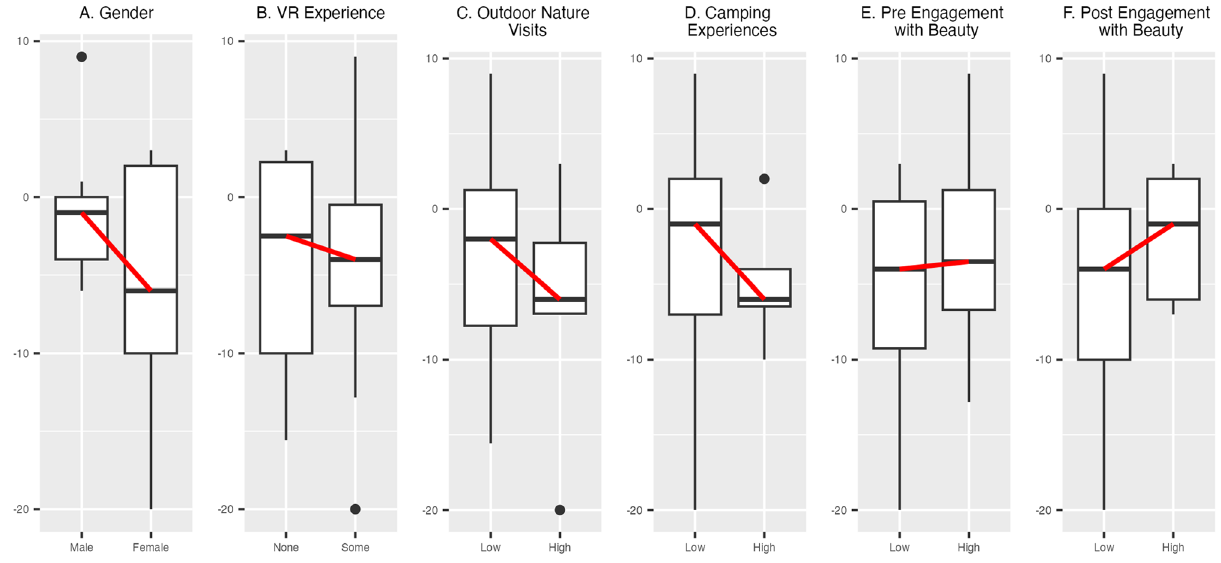
Figure 2. Moderating effects of gender ( A ), VR experience ( B ), exposure to outdoor nature ( C, D ), and engagement with beauty ( E, F ) for impacts of virtual nature on changes in worry (N = 23). Greater negative values correspond to stronger mental health exposure benefits. Red lines show changes in median values between